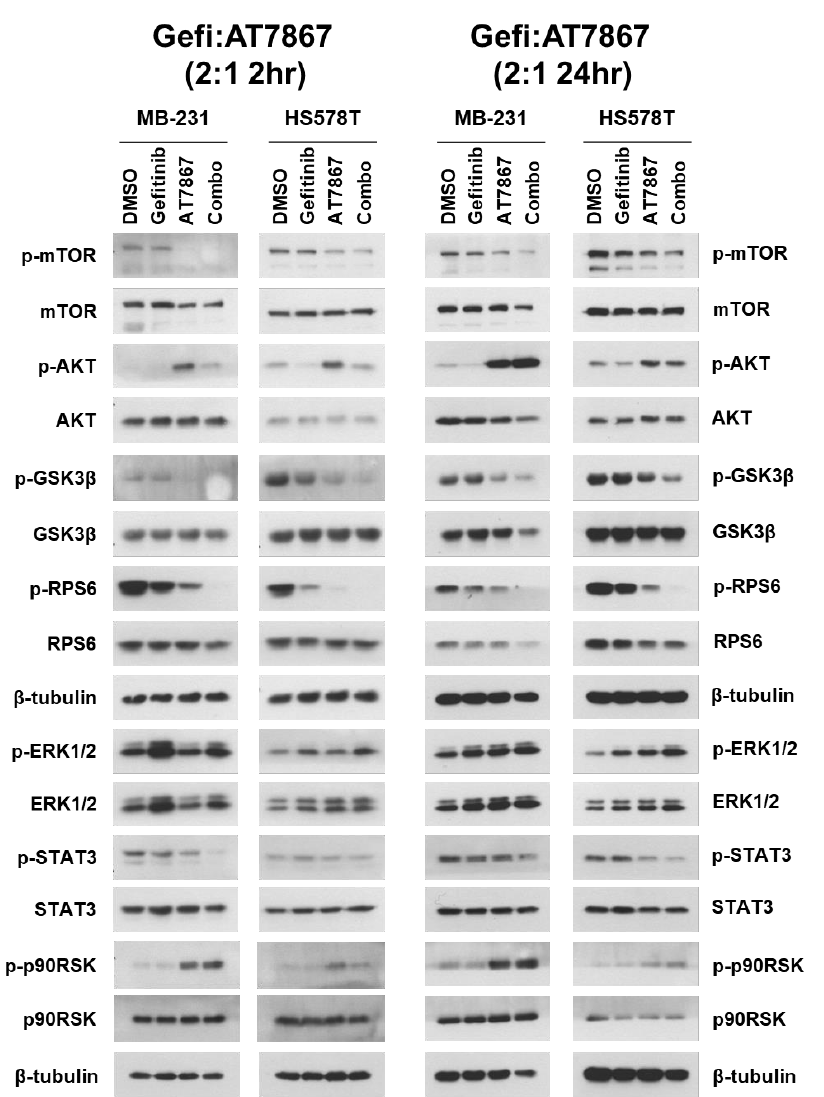
Figure 4. Cell signaling in Gefi+AT7867-treated TNBC cells. Cells were treated with different drug combinations for indicated times. Cell lysates were subjected to Western blot (Figure S1) analysis with antibodies for indicated proteins.